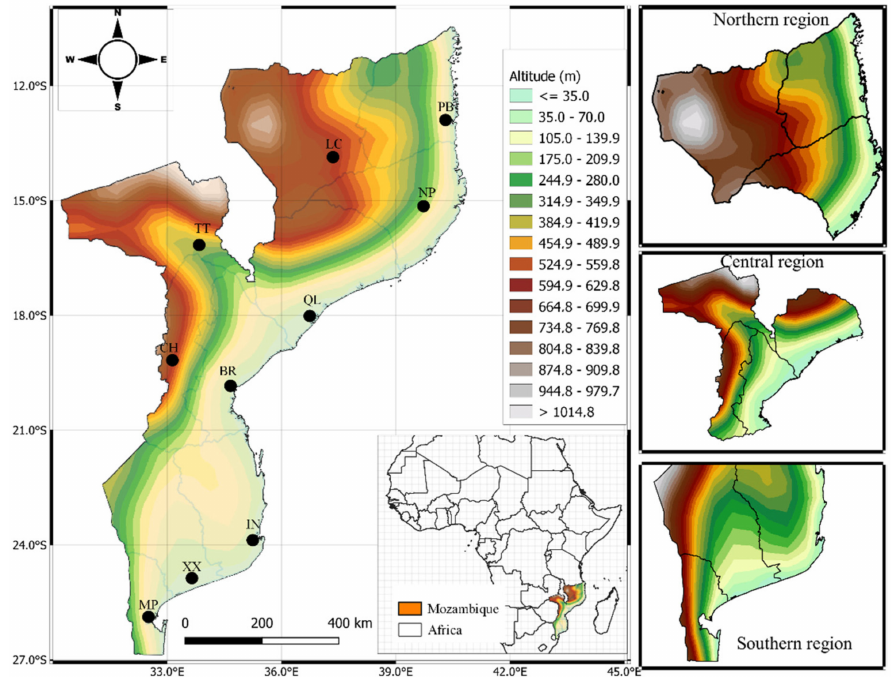
Figure 1. Topography and geographical location of the study domain (Mozambique) in Africa. Black marks closed to acronyms represent the geographical location of each weather stations (PB, LC, NP, QL, TT, BR, CH, IN, XX, MP) considered here. The three left panel indicate the administrative sub-regions: northern, central, and southern